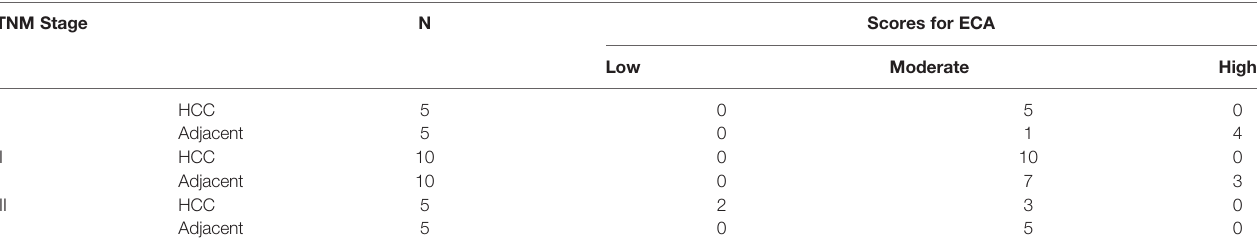
Membranestainingwasscoredaccordingtofourcategories:0for ‘ nostaining ’ ,1+for ‘ lightstainingvisibleonlyathighmagni fi cation ’ ,2+for ‘ intermediatestaining ’ and3+for ‘ darkstaining of linear membrane. Scores = 1 × (% of 1+ cells) + 2 × (% of 2+ cells) + 3 × (% of 3+ cells) (23). Low: score ＜ 100; Moderate: 100 ＜ score ＜ 200; High: score ＞